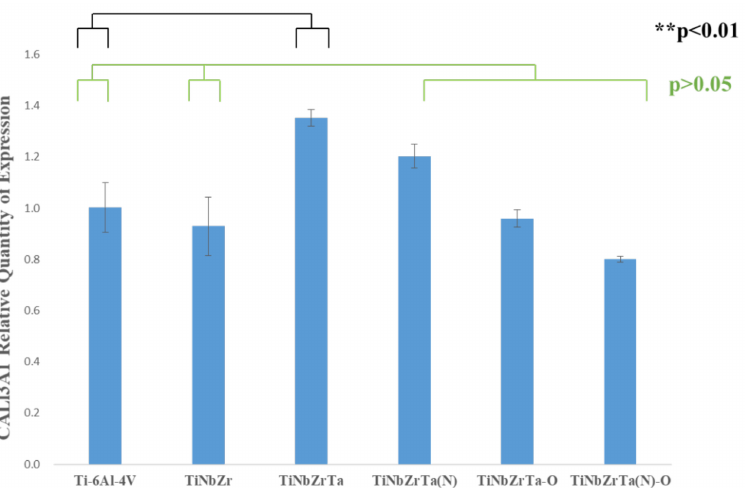
Figure 12. Col3 α 1 gene expression of L-929 cultured on uncoated Ti-6Al-4V and TiNbZrTa series films for three days. ** represents significance among groups ( p < 0.01); no asterisk represents nonsignificance among groups ( p > 0.05).